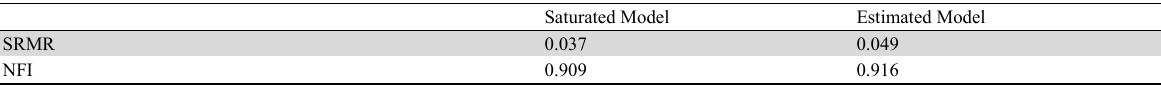
Model fit indices Saturated Model Estimated Model SRMR 0.037 0.049 NFI 0.909 0.916